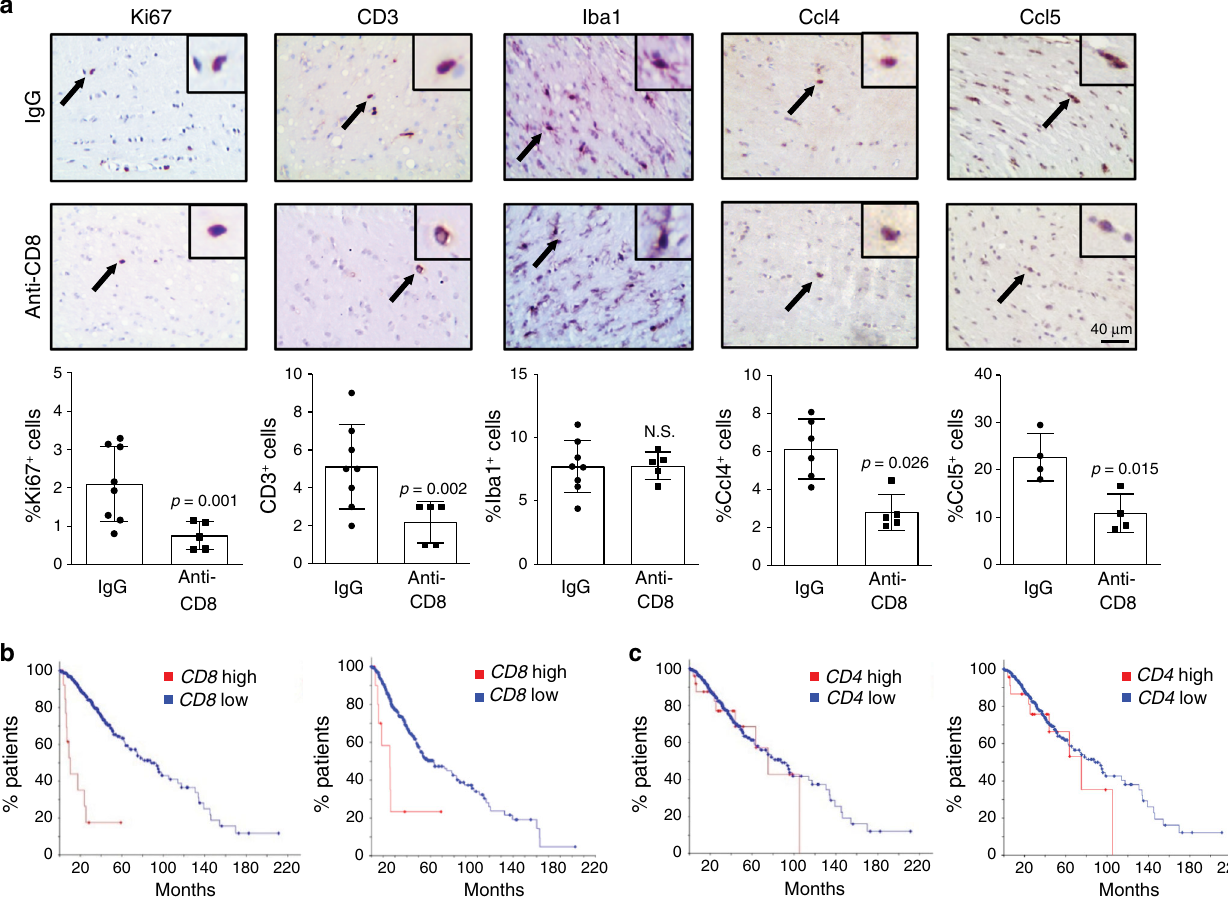
Fig. 6 CD8 + T cells control Nf1 optic glioma growth. a Immunohistochemistry revealed that anti-CD8 antibody treatment reduced the number of CD3 + T cells, as well as the percentage of Ki67 + cells, Ccl4 + cells, and Ccl5 + cells, in Nf1 optic glioma specimens. Black arrows denote representative immunopositive cells. Scale bar, 40 µ m. No differences in microglia (%Iba1 + cells) content were observed in anti-CD8 treated mice compared to the IgG control group. Bar graphs represent the means± SEM of %Ki67 + cells, IgG, n = 8; anti-CD8, n = 5; CD3 + cells, IgG, n = 8; anti-CD8, n = 5; %Iba1 + cells, IgG, n = 8; anti-CD8, n = 5; %Ccl4 + cells, IgG, n = 6; anti-CD8, n = 5; %Ccl5 + cells, IgG, n = 4; anti-CD8, n = 4, independent biological samples. Two- tailed Student ’ s t -test. Exact P values are indicated within each panel; N.S.; not signi fi cant. From left to right in each panel: a % Ki67 + cells, P = 0.001; CD3 + cells, P = 0.002; %Iba1 + cells, N.S.; %Ccl4 + cells, P = 0.026; % Ccl5 + cells, P = 0.015. b Kaplan – Meier survival analysis (Brain Lower Grade Glioma TCGA Provisional [left panel; P = 6.72e – 13] and TCGA PanCancer Atlas [right panel; P = 7.11e − 14] datasets) demonstrates that non-overlapping patients with LGG and high tumor CD8 expression have shorter survival time, while c high CD4 expression was not associated with reduced survival time (Brain Lower Grade Glioma TCGA Provisional [left panel; P = 0.371] and TCGA PanCancer Atlas [right panel; P = 0.598]